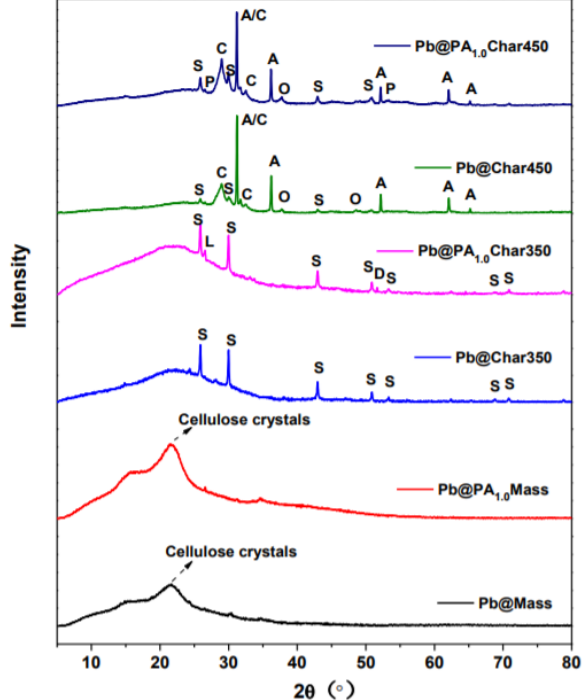
Figure 6. XRD patterns of two biomass and four char samples (A: Pb, C: Pb 3 (CO 3 )(OH) 2 , D: Ca 8 Pb 2 (PO 4 ) 6 (OH) 2 , L: Pb 9 (PO 4 ) 6 , O: PbO, P: Pb 5 (PO 4 ) 3 (OH), and S: PbS). Water 2020 , 12 , x FOR PEER REVIEW